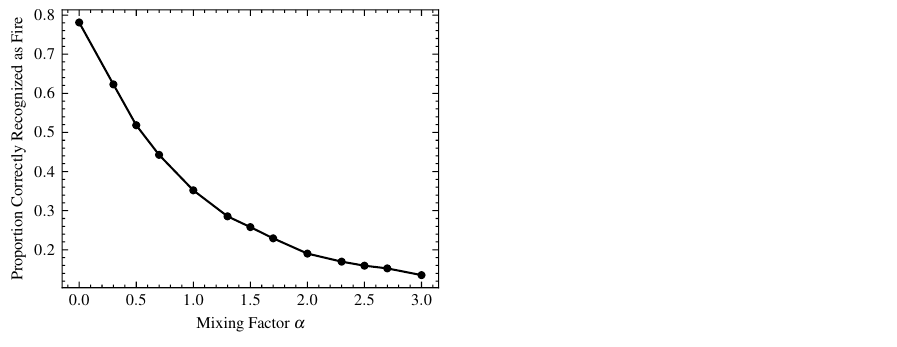
Figure 5. The proportion of instances the data pipeline correctly recognizes as wildfire versus the mixing factor α , the amount of forest sound being mixed in to the wildfire sound. Table 1. Model Performance on Test Dataset with Data